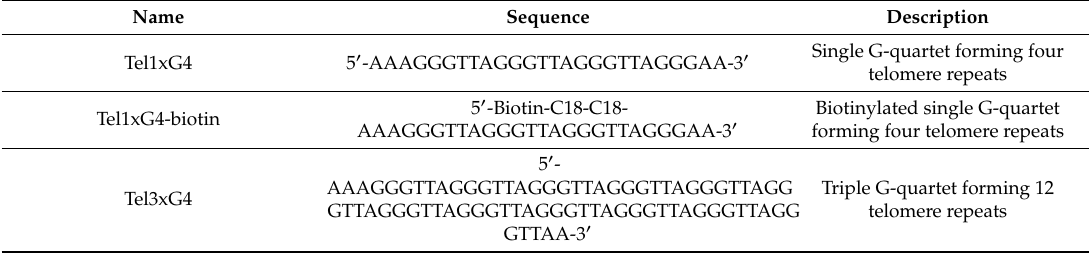
Table 1. DNA sequences used in this